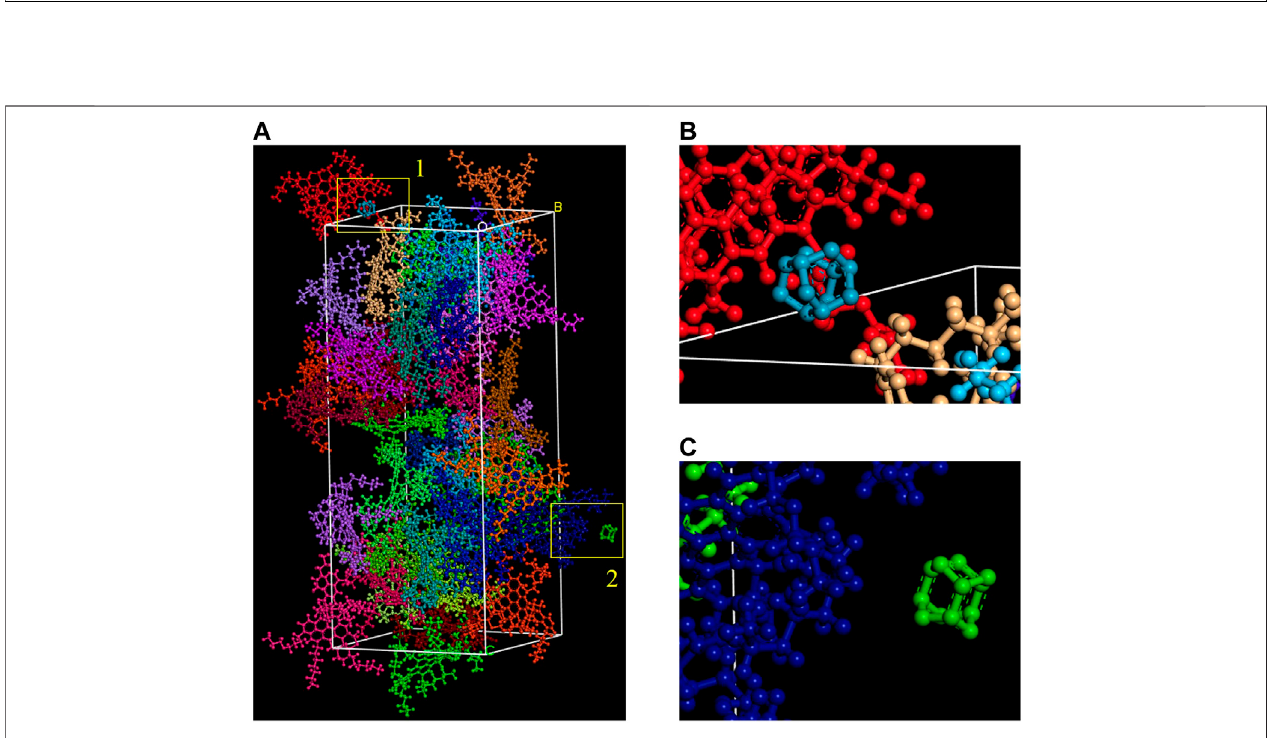
FIGURE 8 | Molecular structures of 1.0% CNT1 modi fi ed PEN70 asphalt after self-healing at 55 ° C: (A) original; (B) enlarged Area 1; (C) enlarged Area 2.